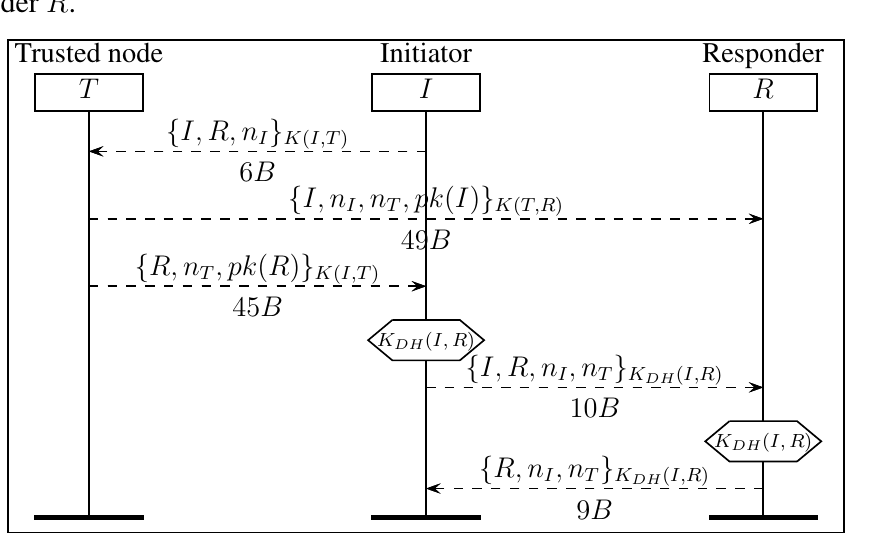
( I, R ) is computed by the initiator I and DH